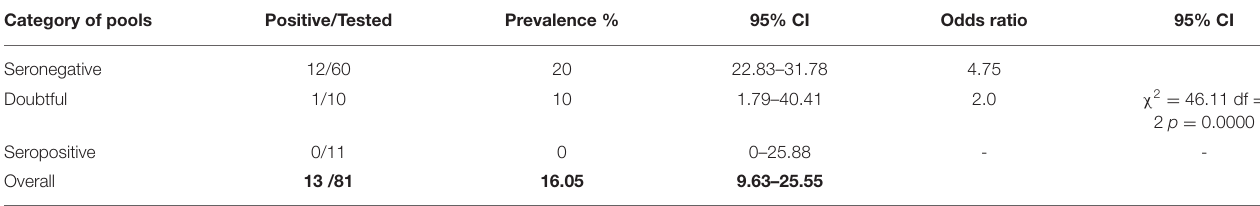
TABLE 5 | Detection of Coxiella burnetii DNA in pooled blood samples. Category of pools Positive/Tested Prevalence